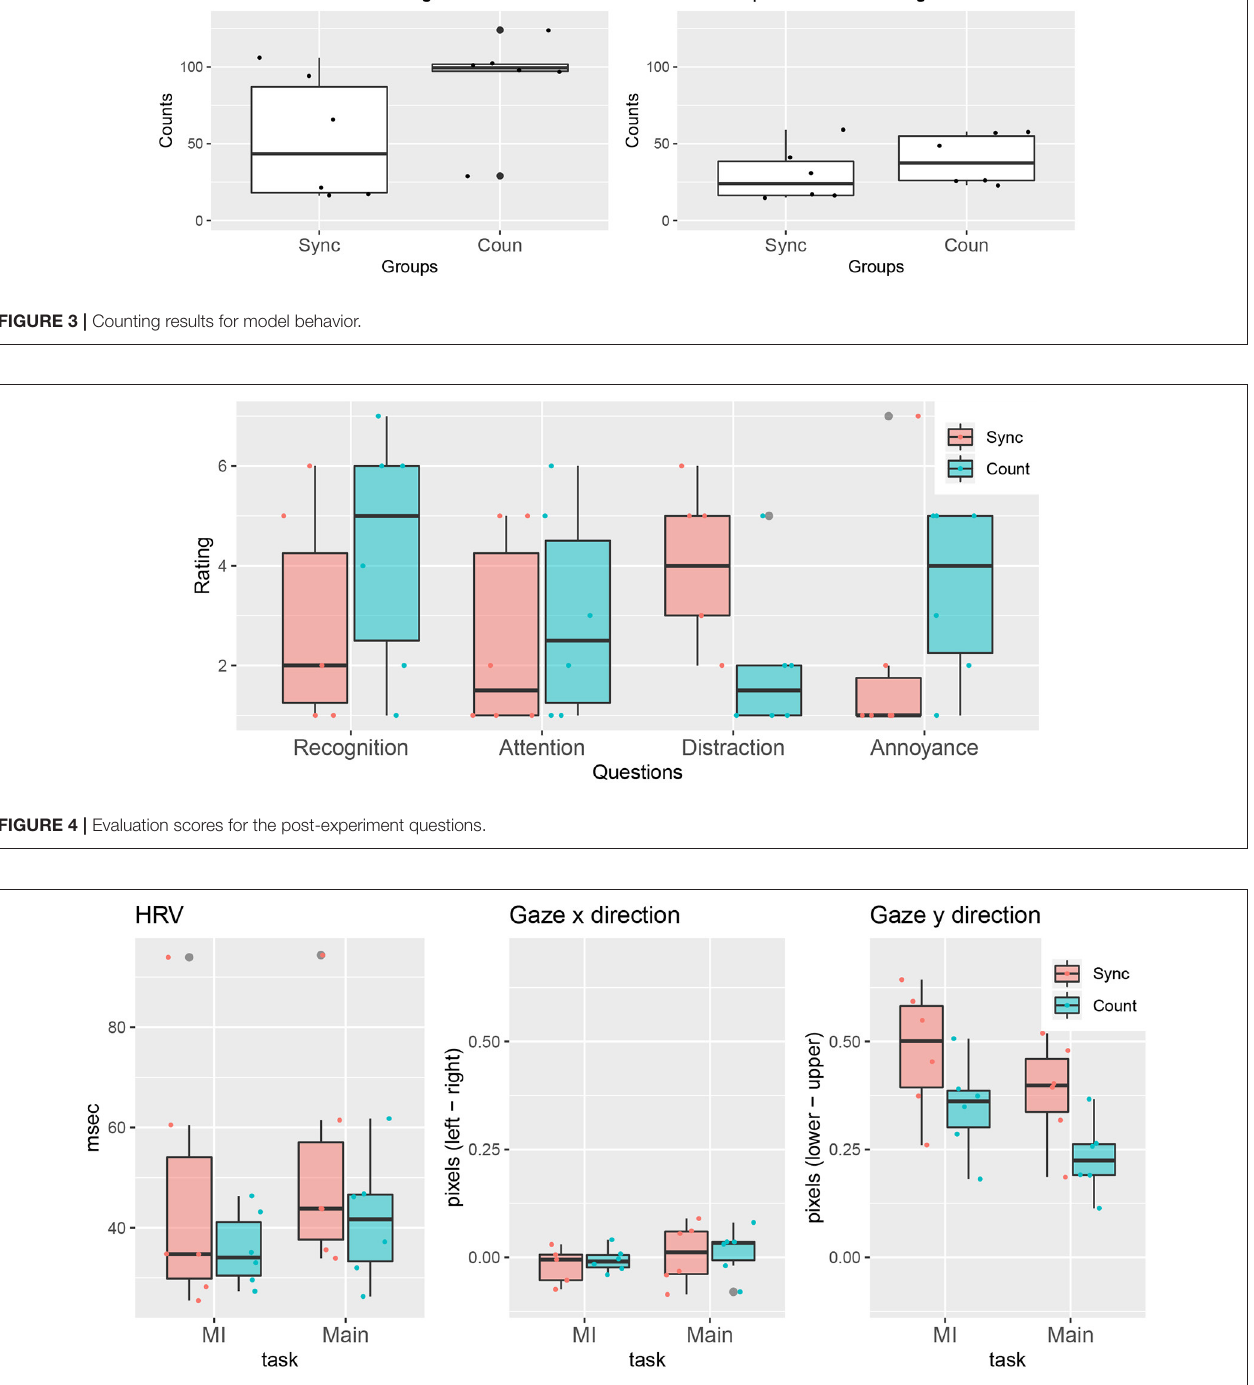
FIGURE 5 | HRV and gaze